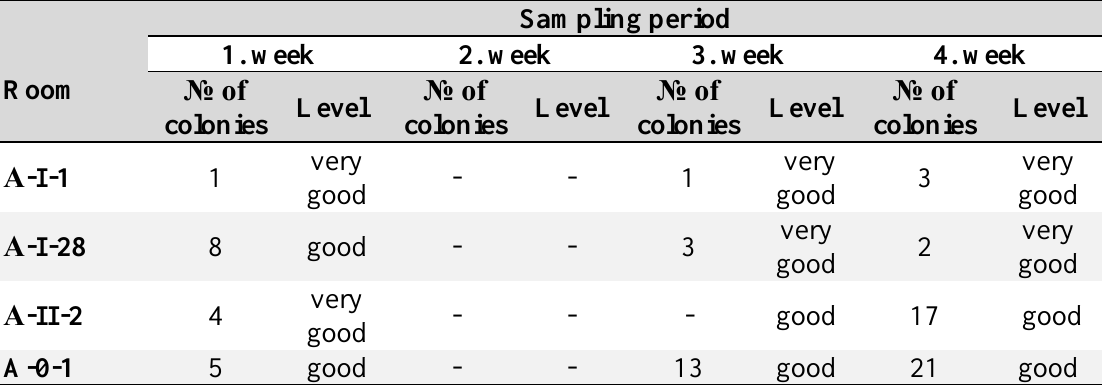
Table 6. The index of microbiological air contamination during the month of